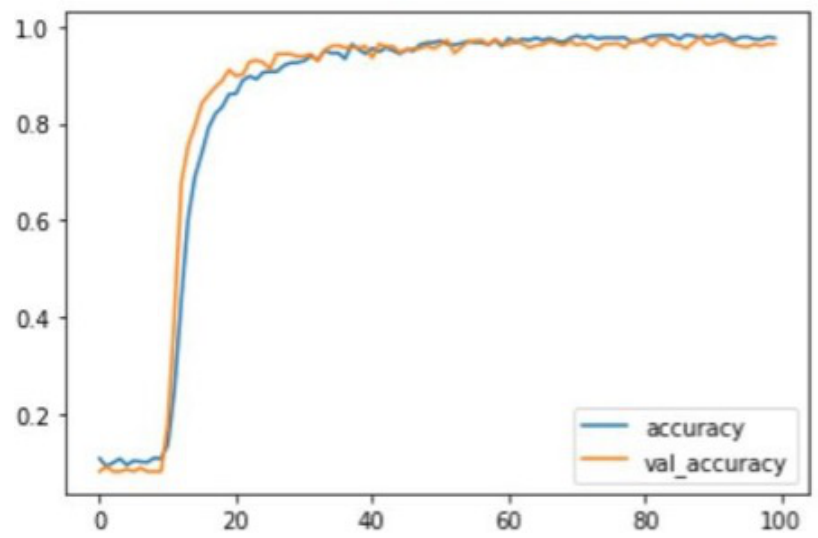
Figure 13. Graph of CNN model training and testing accuracy against the number of epochs.